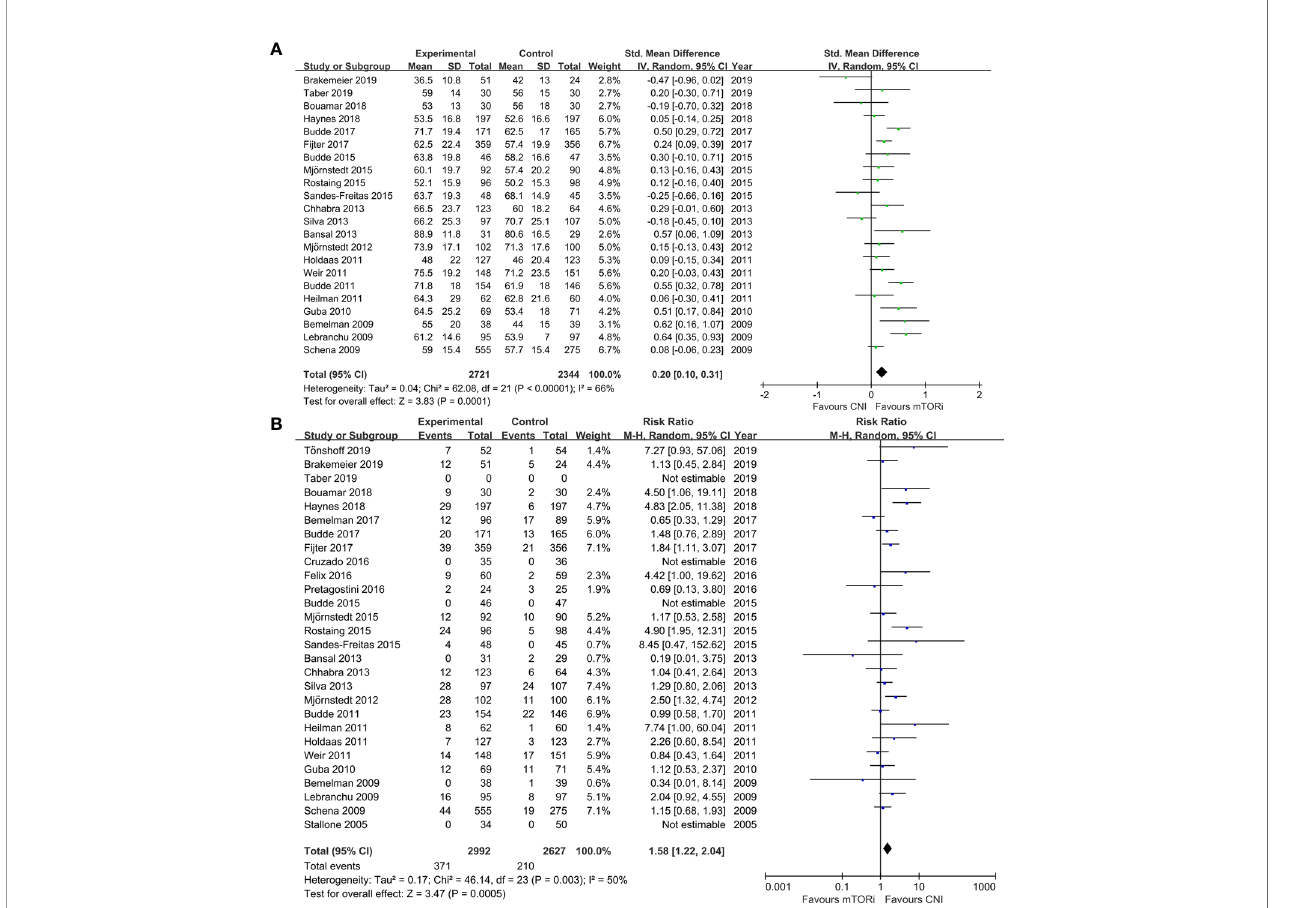
FIGURE 3 | The forest plot of studies that compared conversion from CNIs to mTOR inhibitors versus maintenance of CNI therapy for the outcomes of (A) graft loss and (B)